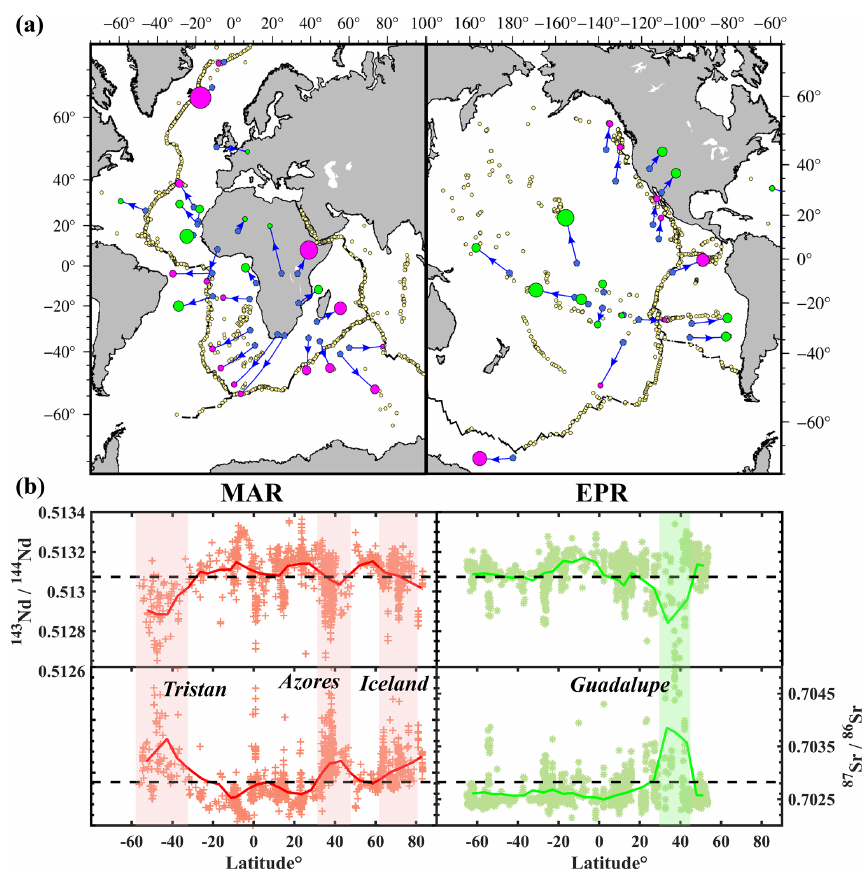
Figure 10. A compilation of hotspots along with spreading ridges in the Atlantic and the Pacific. (a) Distribution of surface hotspots (circles) together with depth-projected source locations at CMB (blue dots) of the plumes based on Jackson et al. (2021). Plumes in magenta circles are mantle plumes interacting with ridges (Ito et al., 2003), and plumes not interacting with ridges are shown as green circles, whose size refers to the plume buoyancy flux (Hoggard et al., 2020). Blue arrows indicate the changes in the position of the plume at the top and bottom of the mantle. Yellow dots are MORB samples mapped in (b) . (b) Plot of radioactive isotope ratios along ridge MORB samples. The data are downloaded from the PetDB database (http://portal.earthchem.org/, last access: 23 August 2021). The colored symbols refer to samples in different mid-ocean ridges. Main hotspots influencing MORBs are labeled with shaded bands. The dashed black lines are the mean MORB isotopes ratio from Gale (2013). Red and green lines are the mean ratios of the samples in the Mid-Atlantic Ridge and EPR, respectively.